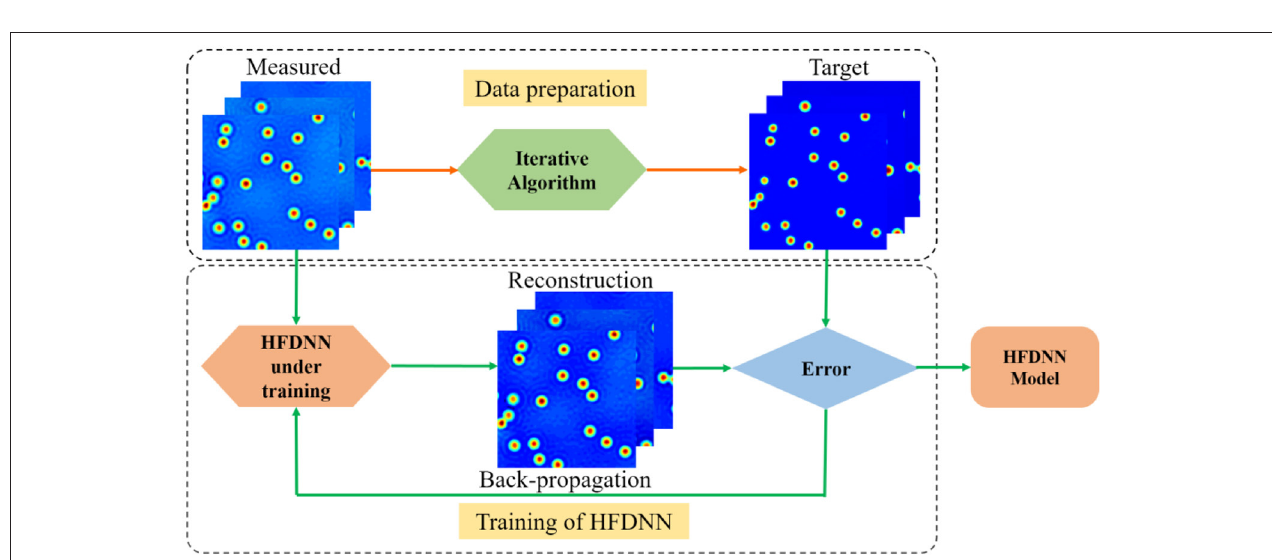
FIGURE 2 | A schematic of the proposed HFDNN architecture. The digits above each layer denote the number of input channels.